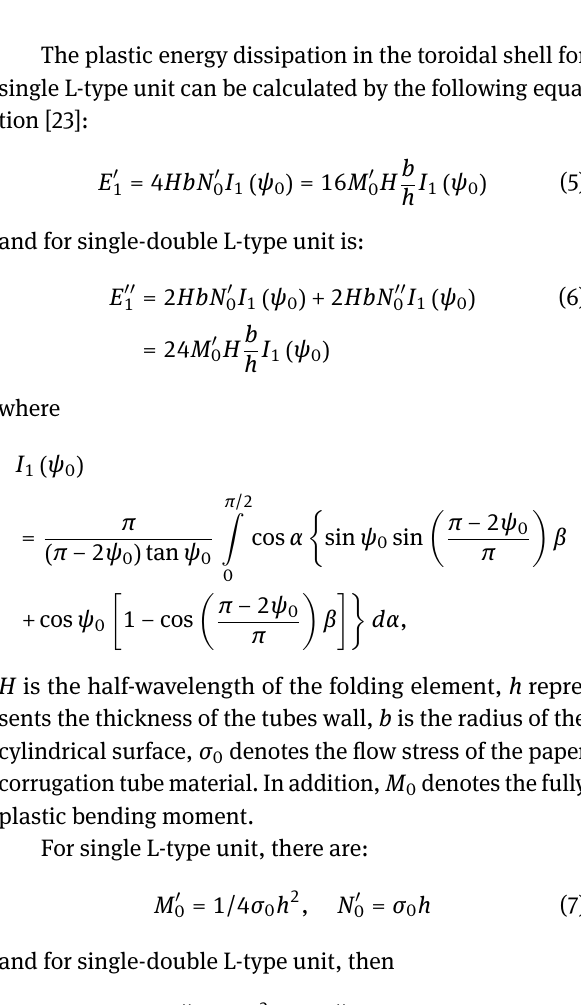
Figure 7: Cross-sectional shapes and L-type units of paper corrugation tubes